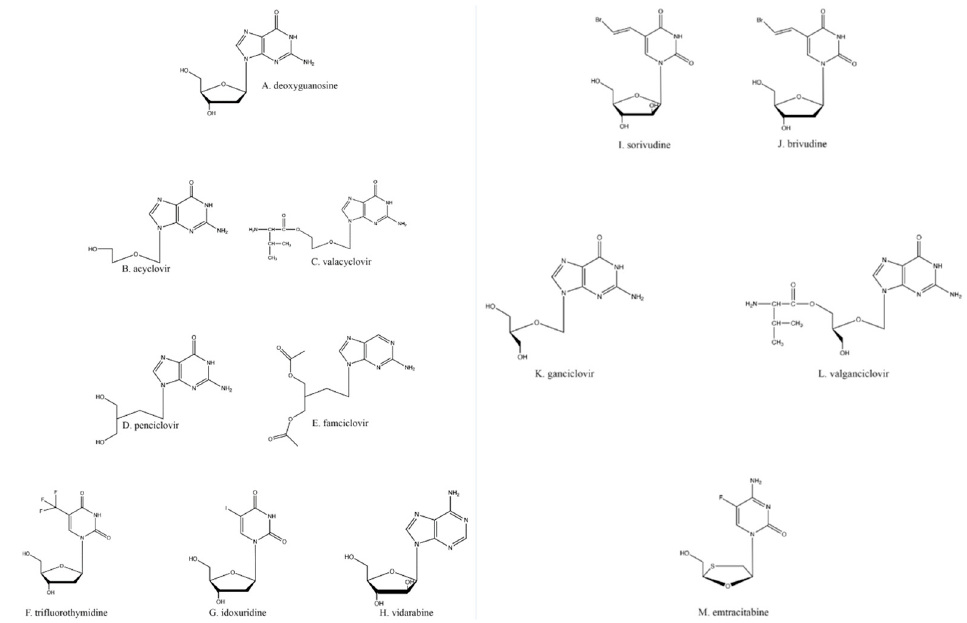
Figure 1. Nucleoside